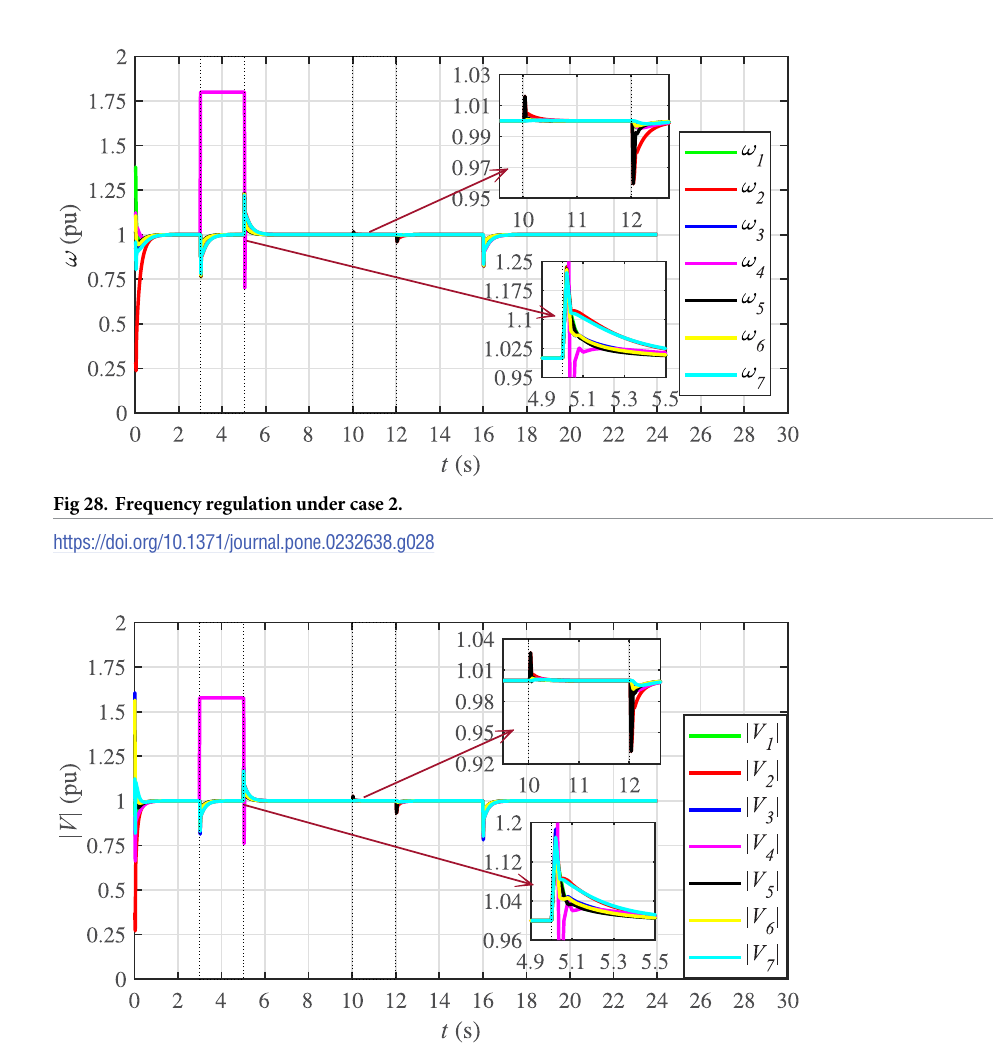
Fig 29. Voltage regulation under case 2.